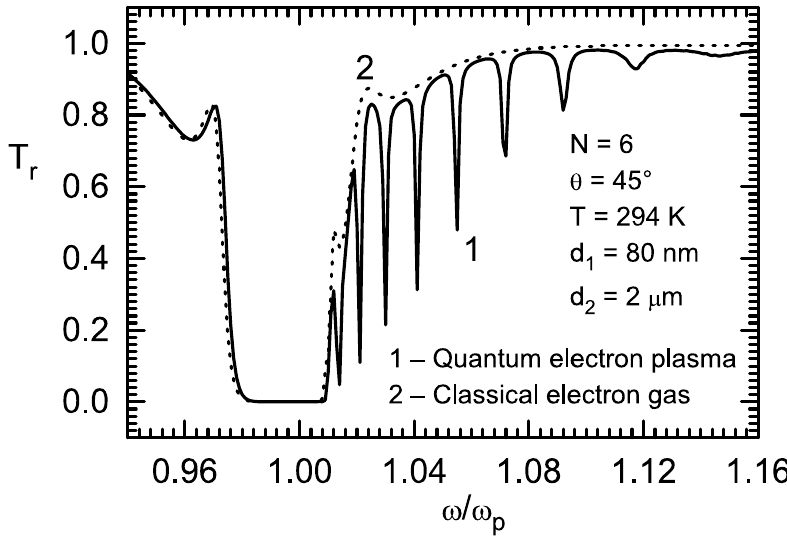
Figure 3. Transmittance T r as a function of the relative frequency ω / ω p at the graphite layer number N = 6, incidence angle θ = 45 ◦ , temperature T = 294 K, graphite layer thickness d 1 = 80 nm, and quartz layer thickness d 2 = 2 µ m: 1—Quantum electron plasma (solid line); 2—Classical electron gas (dotted line).